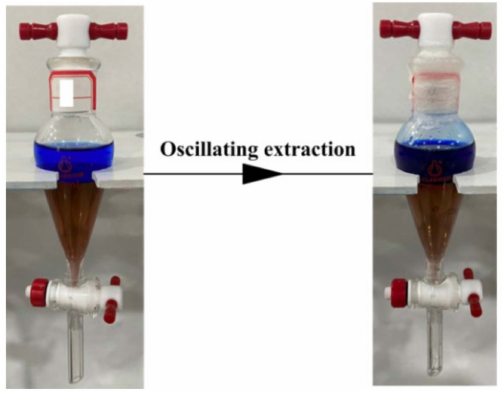
Figure 5. Single-stage extraction for verification experiment.